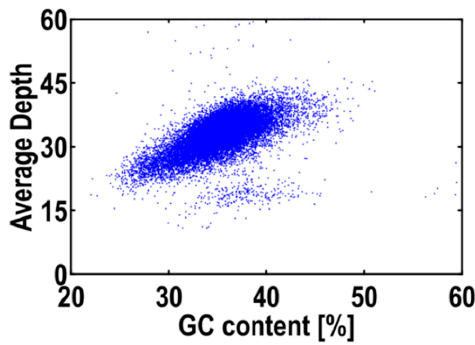
Figure 2. GC content and average sequencing depth of the Luffa cylindrica L. genome data used for assembly. (The x -axis was GC content percent across every 10-kb non-overlapping sliding window.) From the 1,064,011,890 bp genome survey sequence, 431,234 SSRs were identified (Table 3). The motif length of SSR repeats (without mono-nucleotide) included 62.88% di-nucleotide, 31.03% tri- nucleotide, 4.59% tetra-nucleotide, 0.96% penta-nucleotide and 0.54% hexa-nucleotide repeats (Figure 3A). Within the di-nucleotide repeat motifs, the AT/AT accounted for 64.56%, AG/CT for 25.81%, AC/GT for 9.31% and CG/CG only for 0.32% (Figure 3B). The predominant tri-nucleotide motifs, AAT/ATT, AAG/CTT and ATC/ATG repeats, respectively, accounted for 55.36%, 25.86% and 5.79% (Figure 3C). Table 3. Simple sequence repeat types detected in the Luffa cylindrica L. sequences. Searching Item